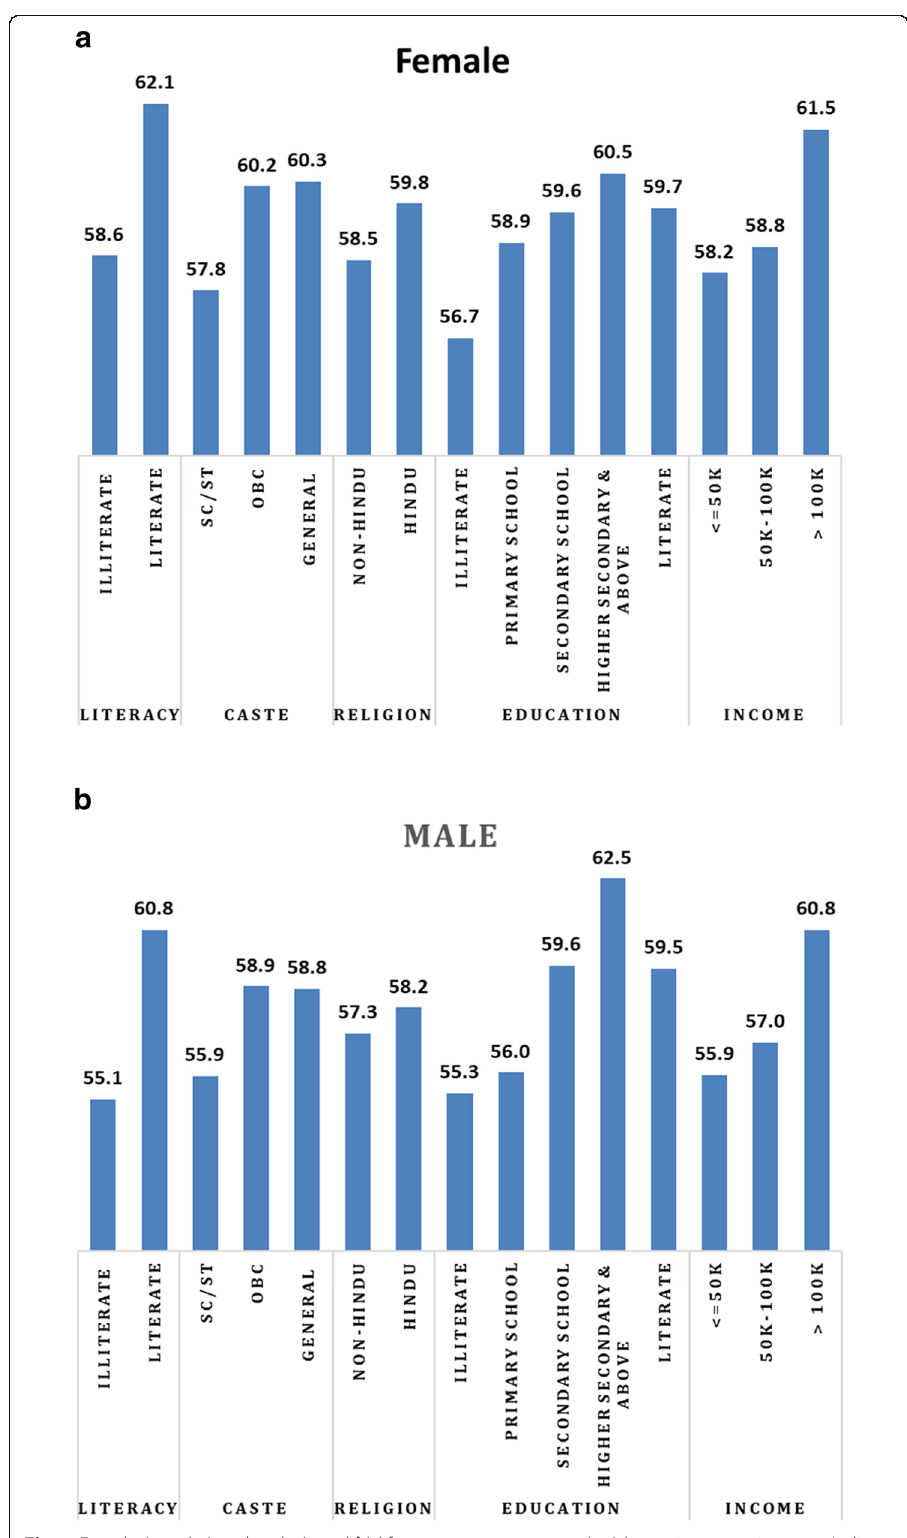
Fig. 1 Female (panel a ) and male (panel b ) life expectancy at age 15 ( e 15 ) by socioeconomic status, India, ca. (1998 – 1999). Source: Authors ’ own calculation from IHDS data, 2011 –